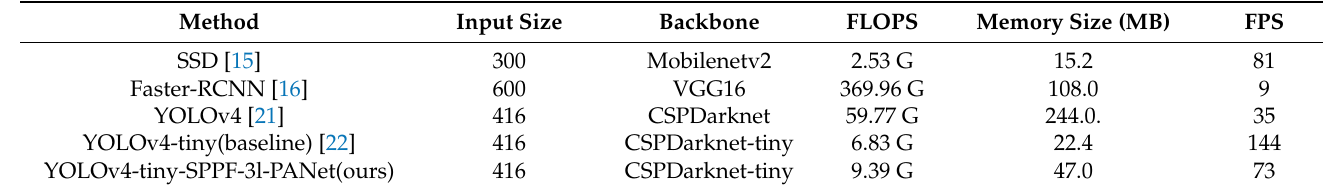
Table 6. Detection speed and model memory size.